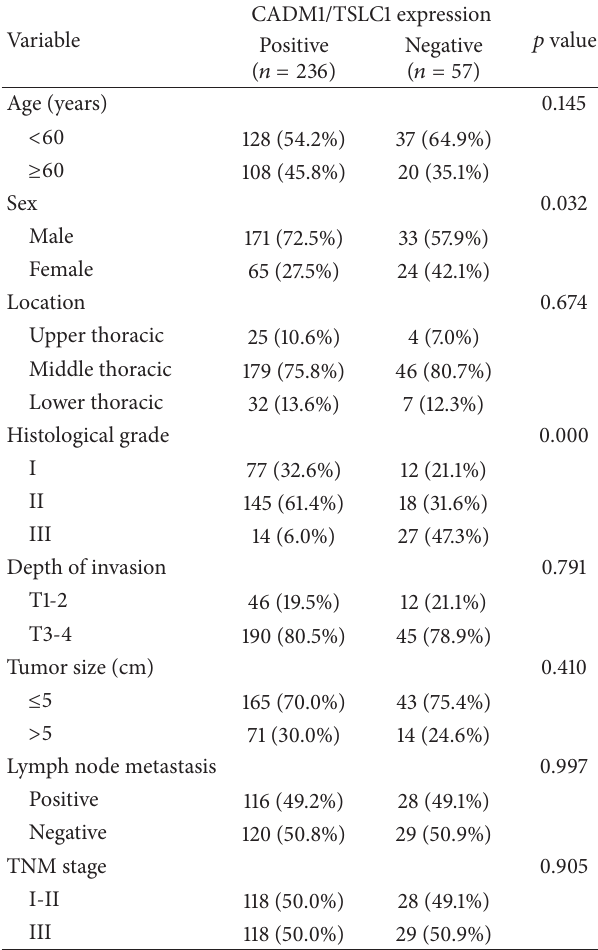
Table 1: Relationship between CADM1/TSLC1 expression and clinicopathological variables of